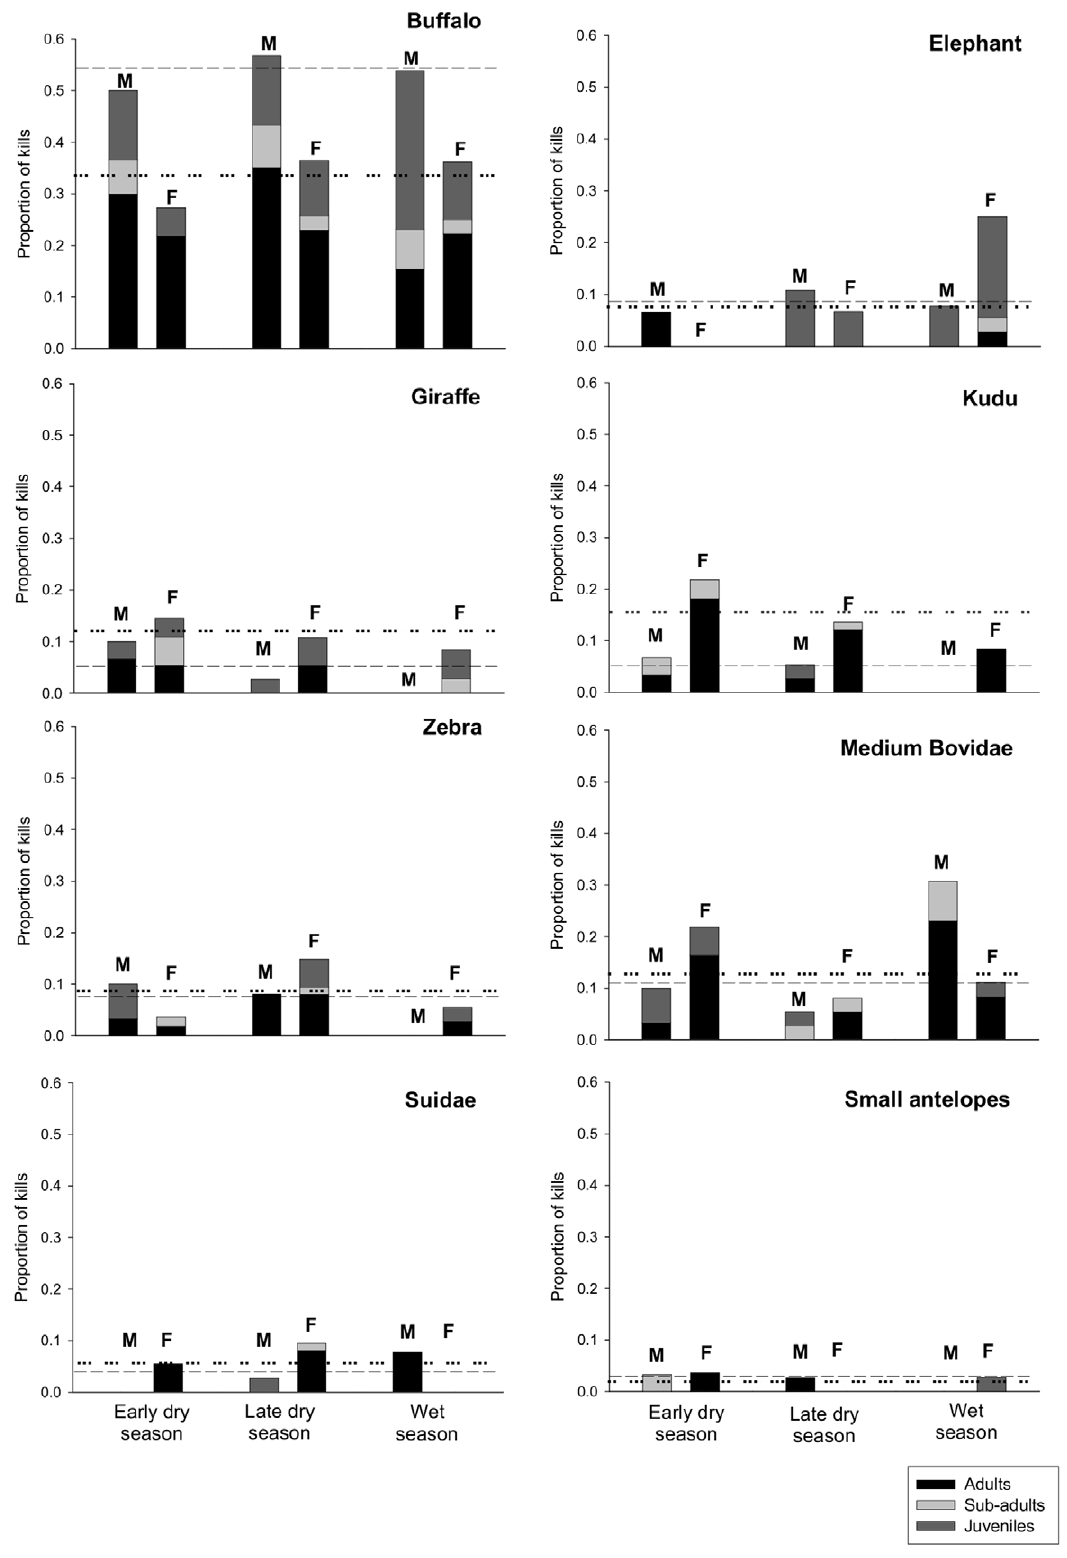
Figure 1. Seasonal variation in the relative contribution by different prey species to lion kills, for males (M) and females (F), distinguishing age class proportions. Dashed and dotted lines indicate mean proportions in the amalgamated kills for males and females respectively.